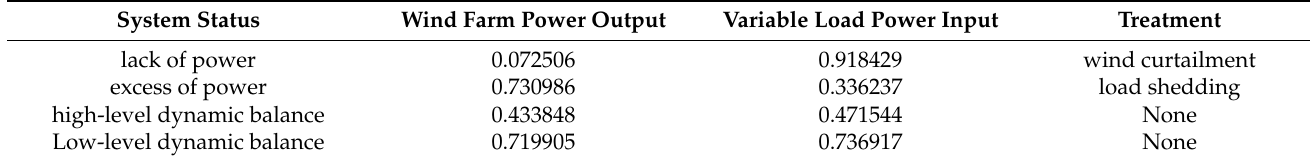
Table 3. Typical scenarios in the modified IEEE RTS-24 bus system.